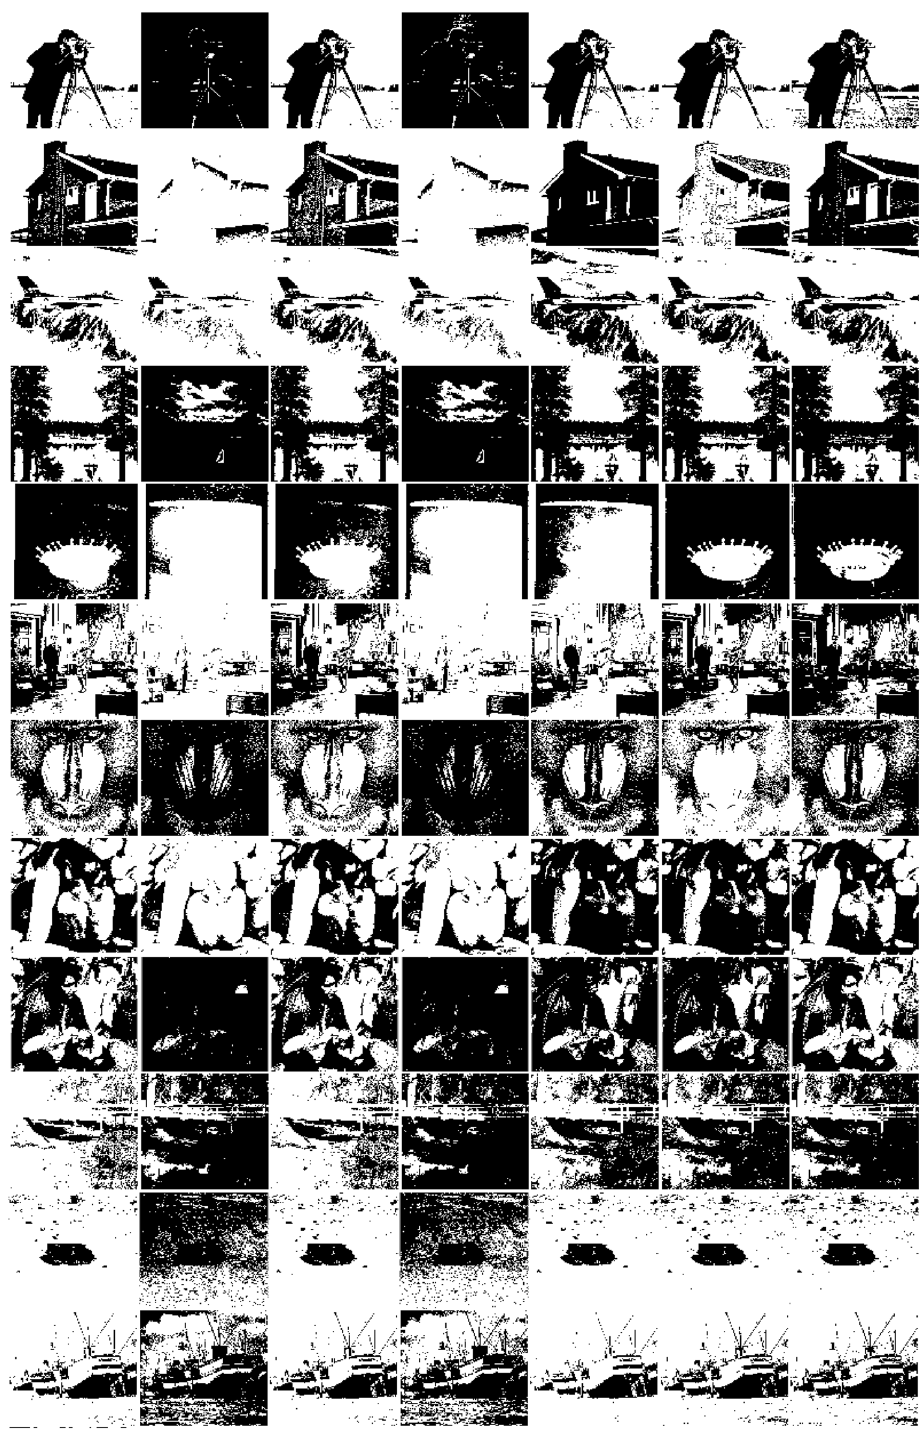
Figure 6. Thresholding segmentation results by using different methods. For each experimental image, the results of OTSU, KSW, CHPSO_otsu, CHPSO_ksw, GLLV, GABOR and WPWLPT methods are displayed side by side from left to